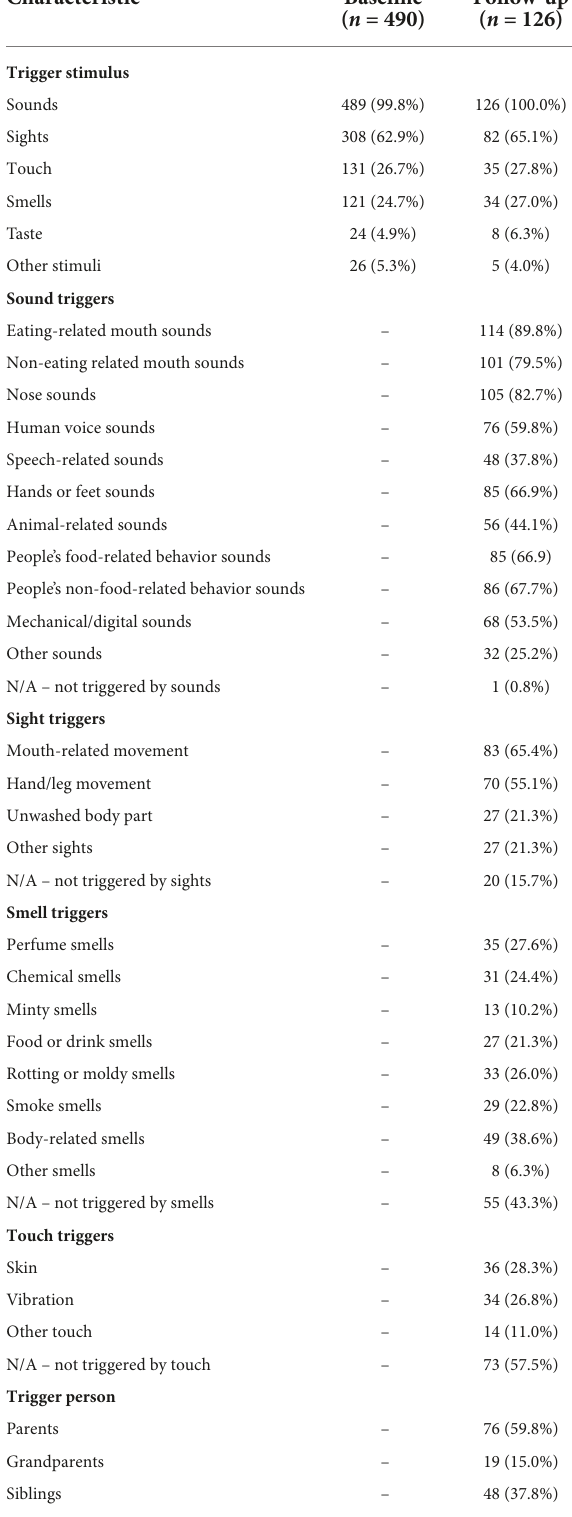
TABLE 3 Number of people with misophonia who report experiencing specific characteristics of triggers or being triggered by particular